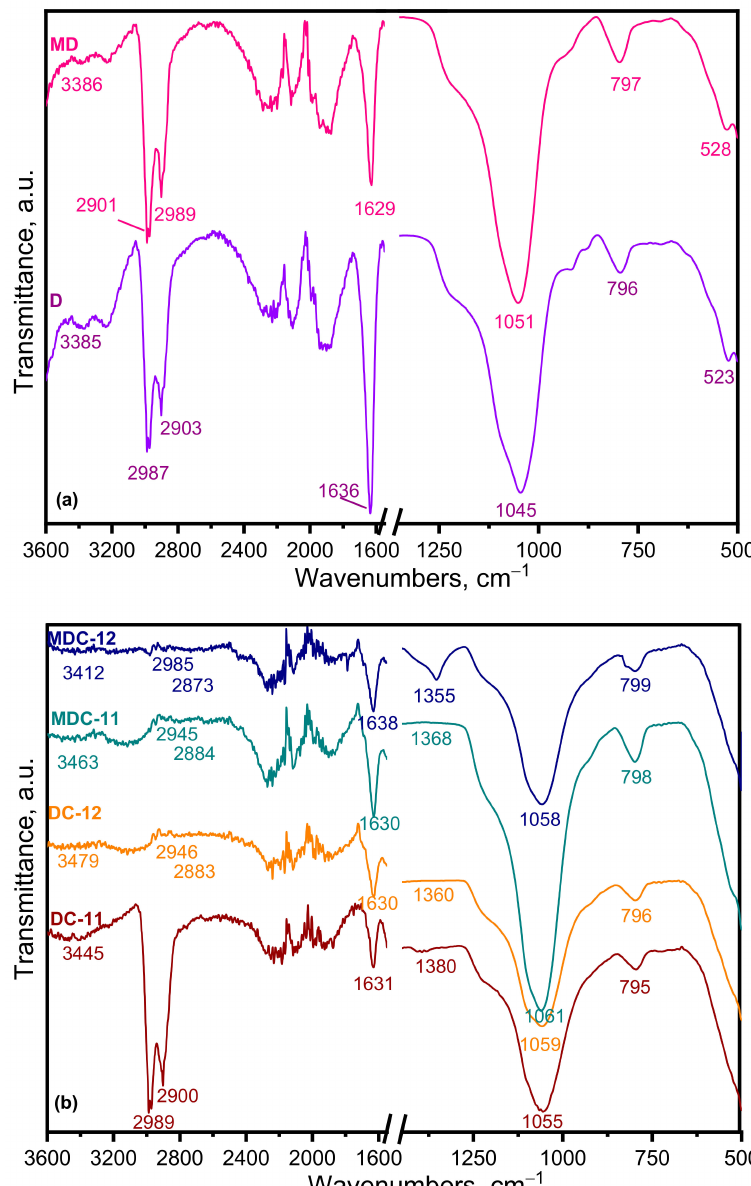
Figure 1. FTIR spectra of ( a ) D, MD, ( b ) DC-11, DC-12, MDC-11, and